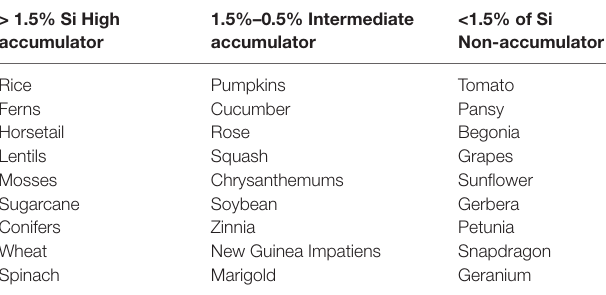
TABLe 1 | Plant categories based on Si uptake capacity (Bakhat et al., 2018). > 1.5% Si High